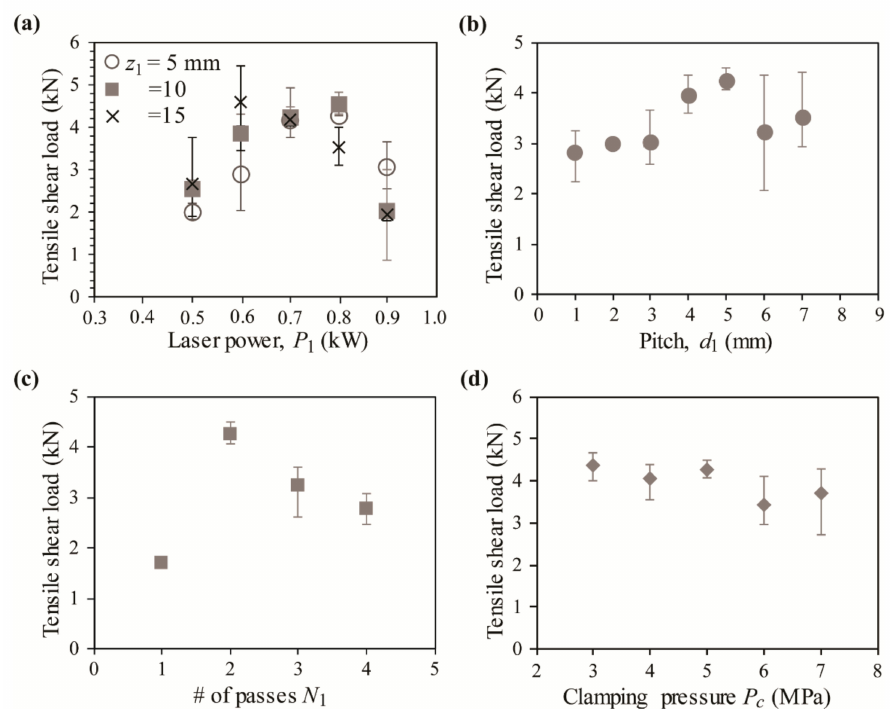
Figure 3. ( a ) Tensile shear load variation with respect to (w.r.t.) laser power, P 1 for laser focal positions z 1 = 5, 10, 15 mm. d 1 = 5 mm, N 1 = 2, P c = 5 MPa, and v 1 = 10 mm / min were used. ( b ) Tensile shear load variation w.r.t. the weld pitch, d 1 . P 1 = 0.7 kW, z 1 = 10 mm, N 1 = 2, P c = 5 MPa, and v 1 = 10 mm / min were used. ( c ) Tensile shear load variation w.r.t. the number of passes N 1 . P 1 = 0.7 kW, z 1 = 10 mm, d 1 = 3 mm, P c = 5 MPa, and v 1 = 10 mm / min were used. ( d ) Tensile shear load variation w.r.t. the clamping pressure P c . P 1 = 0.7 kW, z 1 = 10 mm, d 1 = 5 mm, N 1 = 2, and v 1 = 10 mm / min were